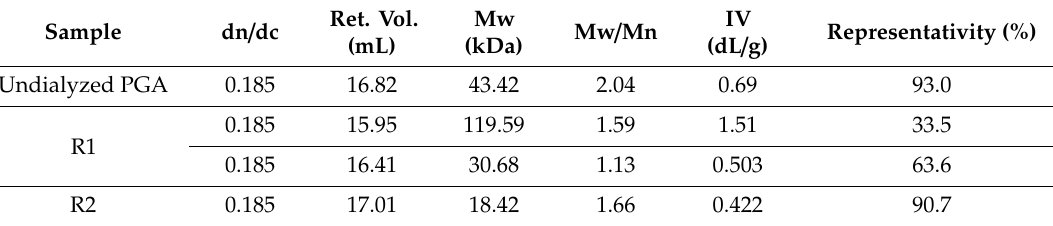
Table 4. SEC–TD characterization of the samples following concentration and diafiltration of the undialyzed PGA on 100 kDa membranes (R1) and of the retentate obtained after concentration and diafiltration of the deriving permeate on 10 kDa membranes (R2). Further experimental details are given in the text.